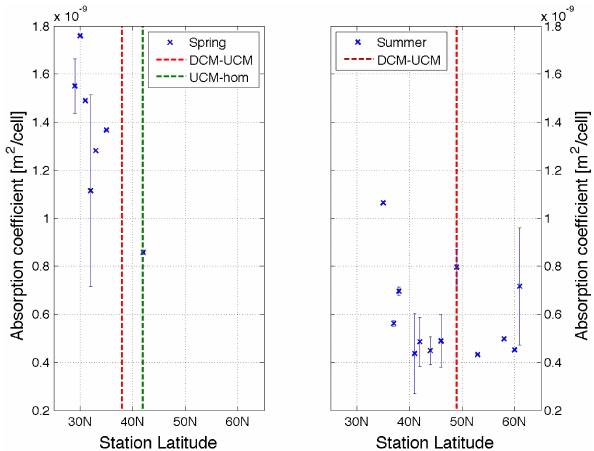
Figure A3. Mean k per station based on irradiance profiles and Chl a concentration profiles measured in spring (left) and summer (right). See caption of Fig. A2 for further